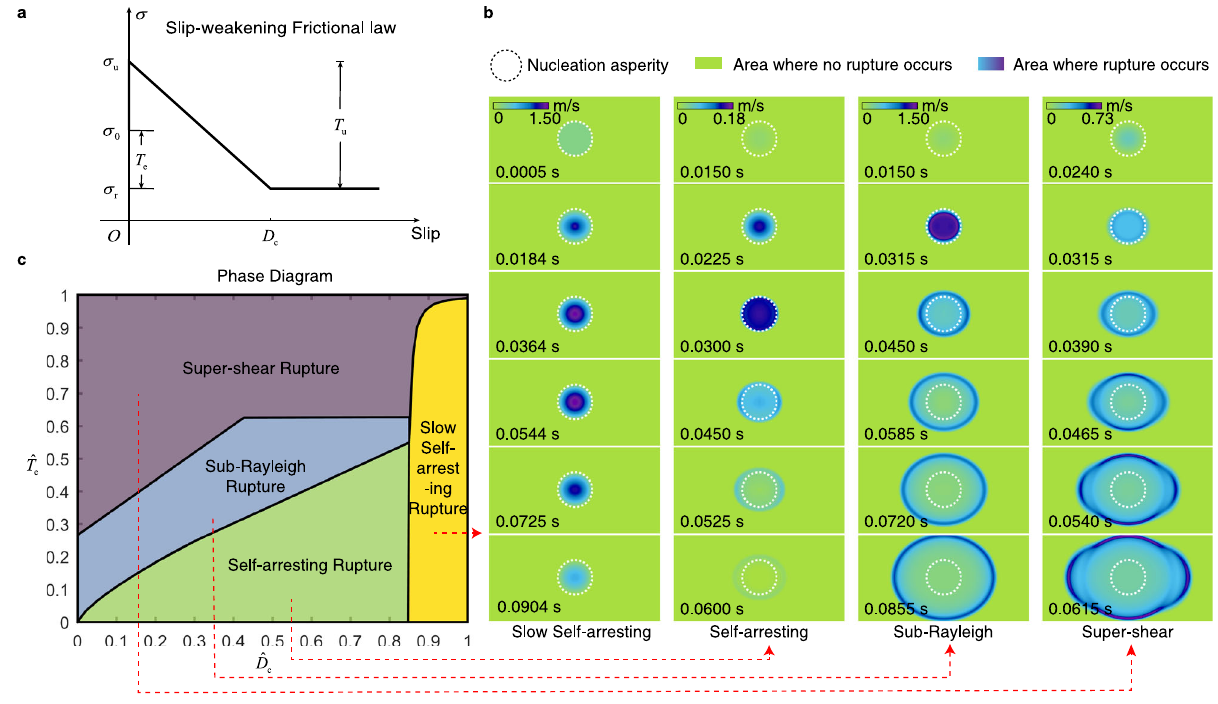
Fig. 1 Phase diagram of rupture dynamic and four types of rupture modes. a Slip-weakening frictional law; σ u , σ 0 , and σ r are the peak strength, initial stress and residual stress, respectively. T u is the breakdown stress drop, T e is the dynamic stress drop. b Four types of rupture modes. The simulated strike- slip faults are shown as the green background area, and the white dashed lines enclose the nucleation asperity. All four types of rupture are under the same initial stress state. c Rupture phase diagram in parameter spaces ( D c , R a , T e , T u ) for four different combinations of friction